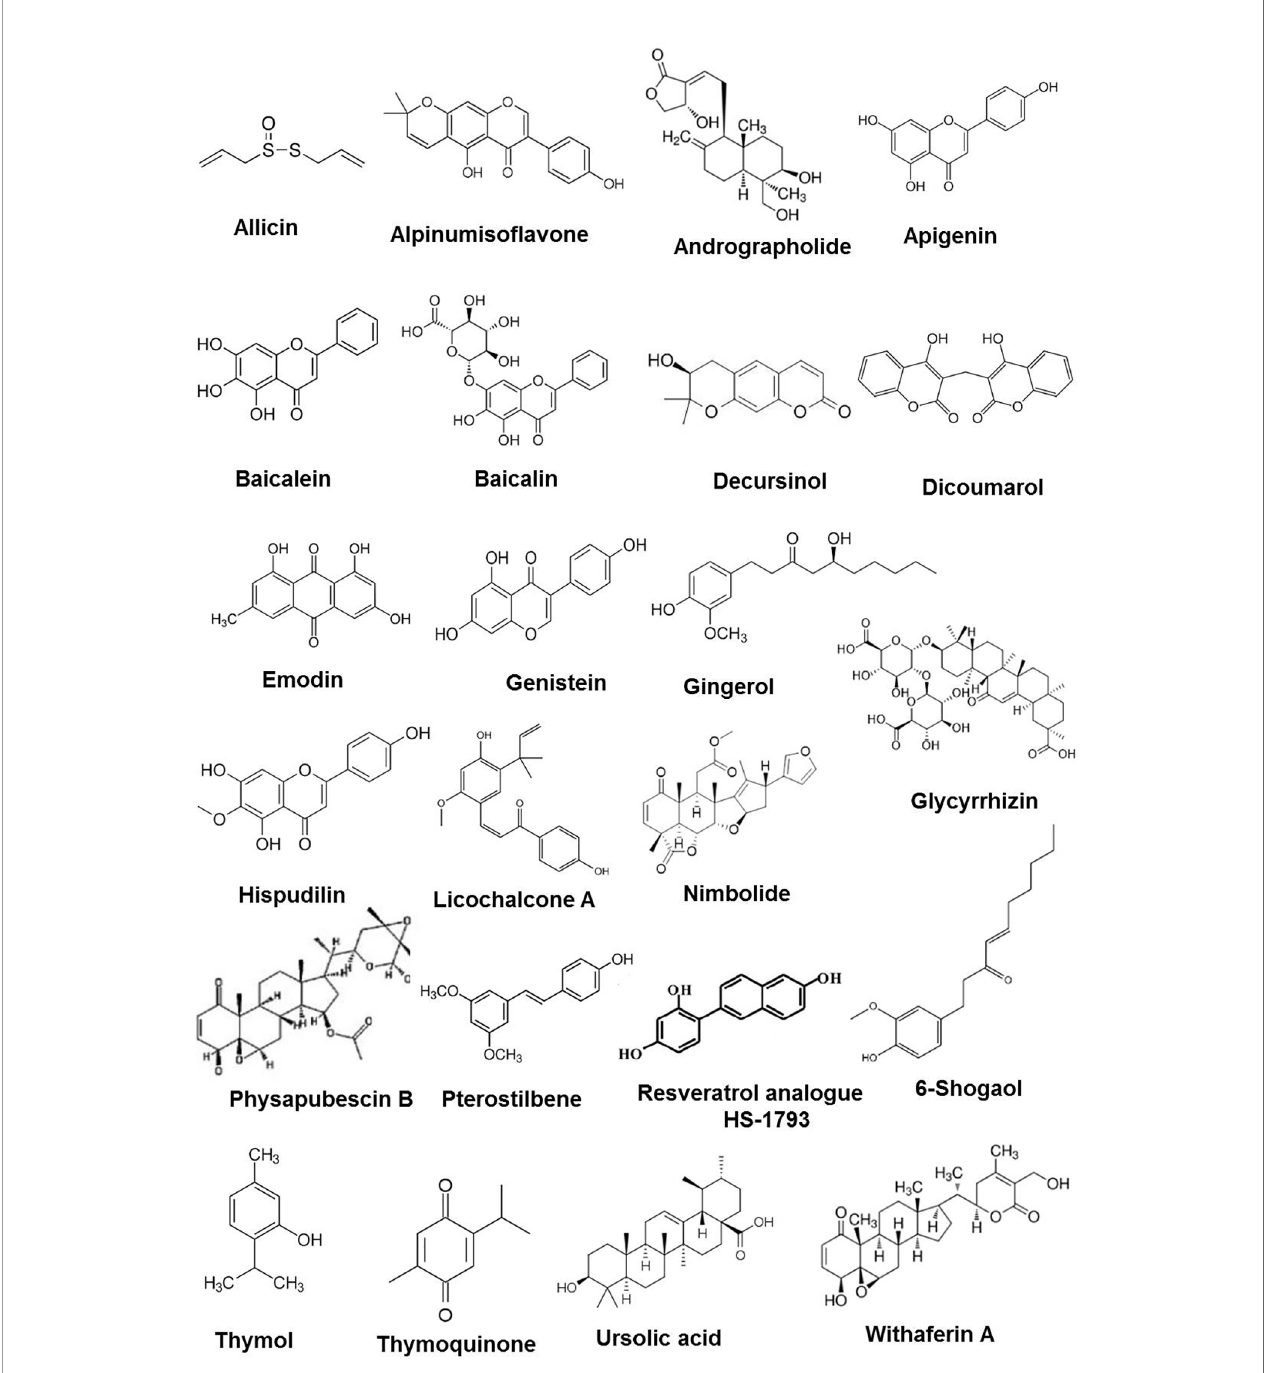
FIGURE 1 | Chemical structures of some anticancer phytochemicals in preclinical